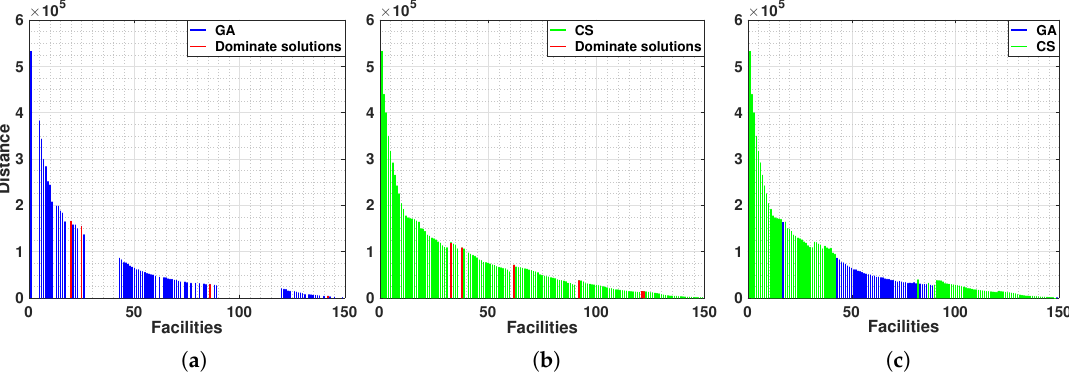
Figure 10. The Pareto set after solving the facility location problem for the London dataset using: genetic algorithms ( a ), crowdsourcing ( b ) and the genetic algorithm complemented by crowdsourcing solutions ( c ).